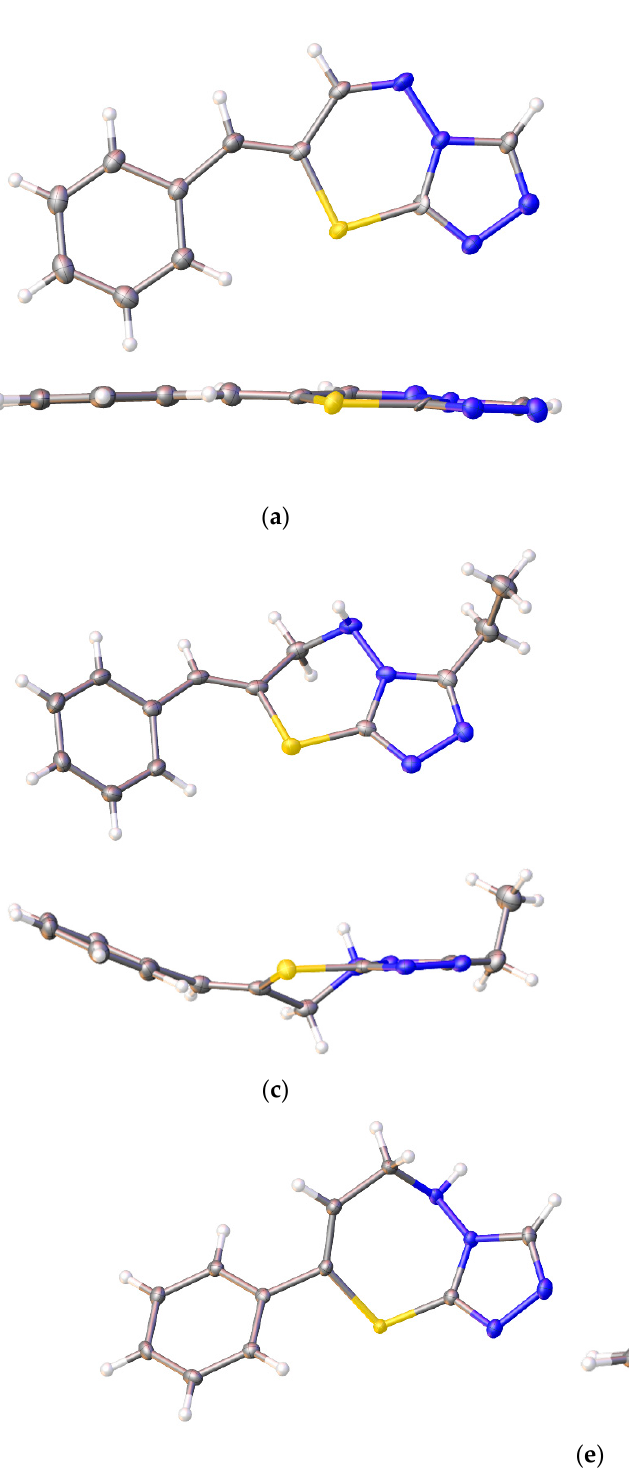
Figure 8. Structures of the compounds ( a ) 6a ; ( b ) 8a ; ( c ) 8c ; ( d ) 7c ; ( e ) 10a .